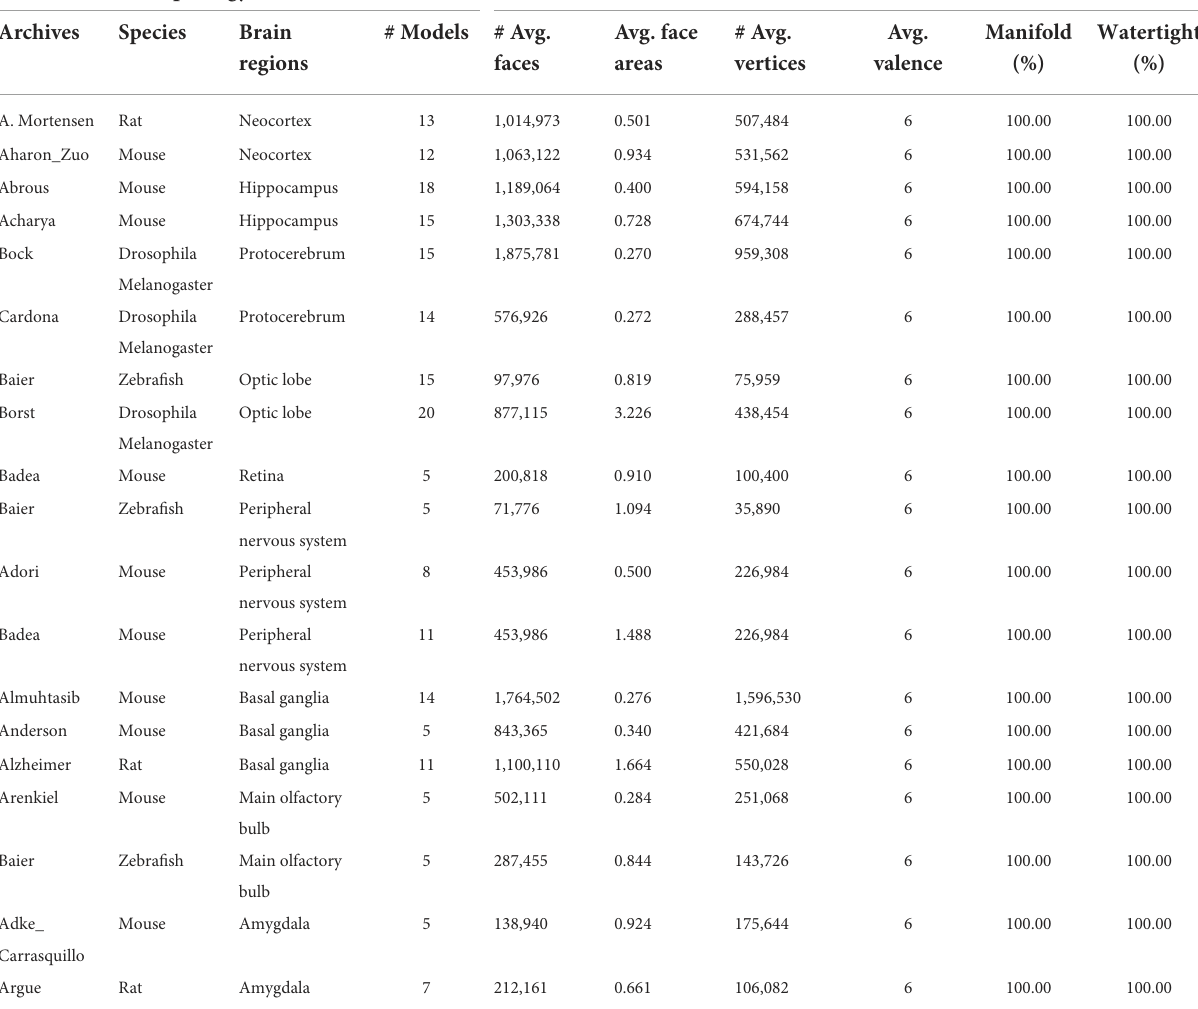
TABLE 3 Attributes of neuronal morphologies from NeuroMorpho.Org and produced membrane meshes averaged from groups of data. Morphology